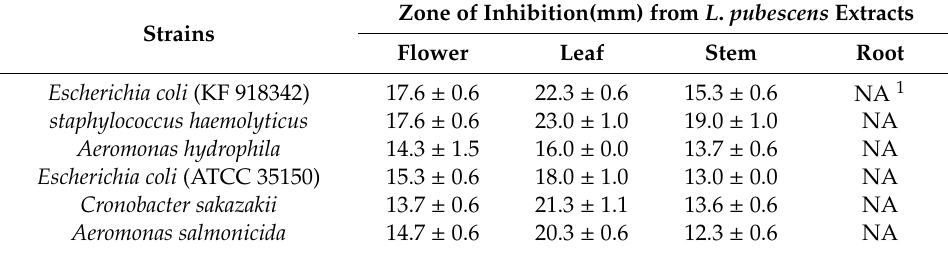
Figure 2. Representative image showing antibacterial activity against a bacterial pathogen. Leaf (L), flower (F), root (R), and stem (S) of Lavandula pubescens . Table 3. Antibacterial activity of different organs of Lavandula pubescens . Each value is the average of three trials ± standard deviation.